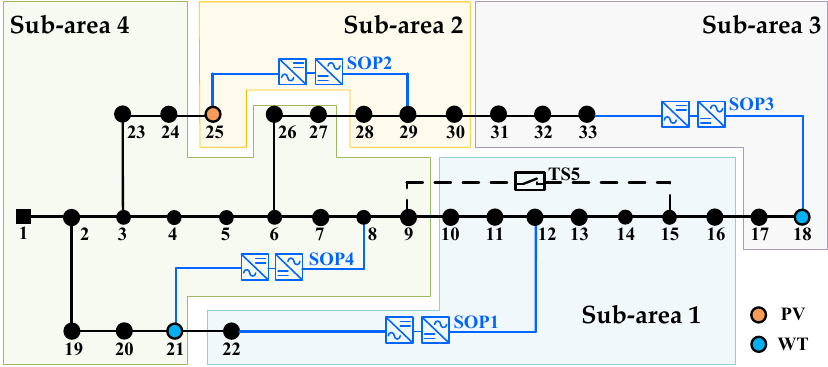
Figure 5. Partitioning result of the modified IEEE 33-node system.